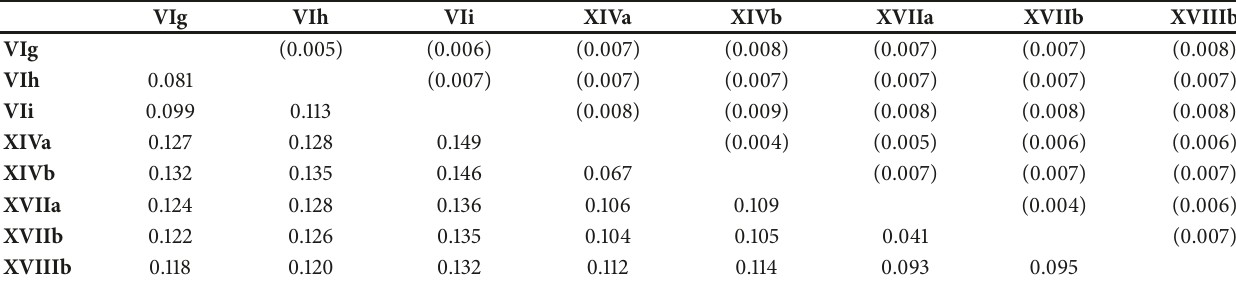
Table 3: Estimates of evolutionary divergence among the virulent NDV genotypes circulating in